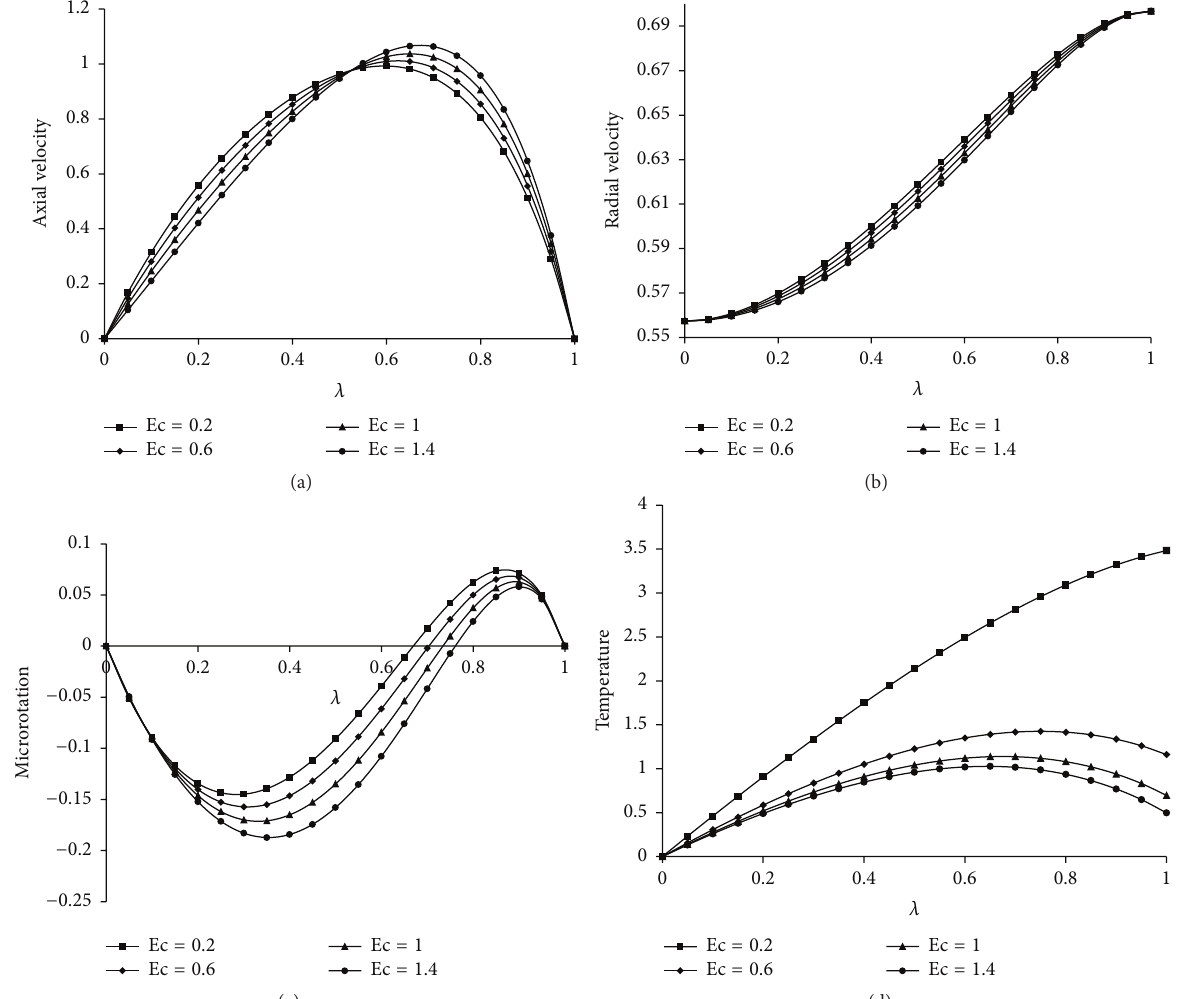
Figure 5: Effect of Ec on (a) axial velocity, (b) radial velocity, (c) microrotation, and (d) temperature for 𝐷 −1 = 2 , Du = 0.2, Gr = 4, Re = 2, Sr = 0.2, Ha = 2, Sc = 0.22, 𝑎 = 0.2 , 𝜓 = 0.8 , 𝑅 = 2 , 𝐽 1 = 2 , 𝑠 1 = 2 , 𝑠 2 = 1 , Gm = 4, Kr = 2, and Pr =